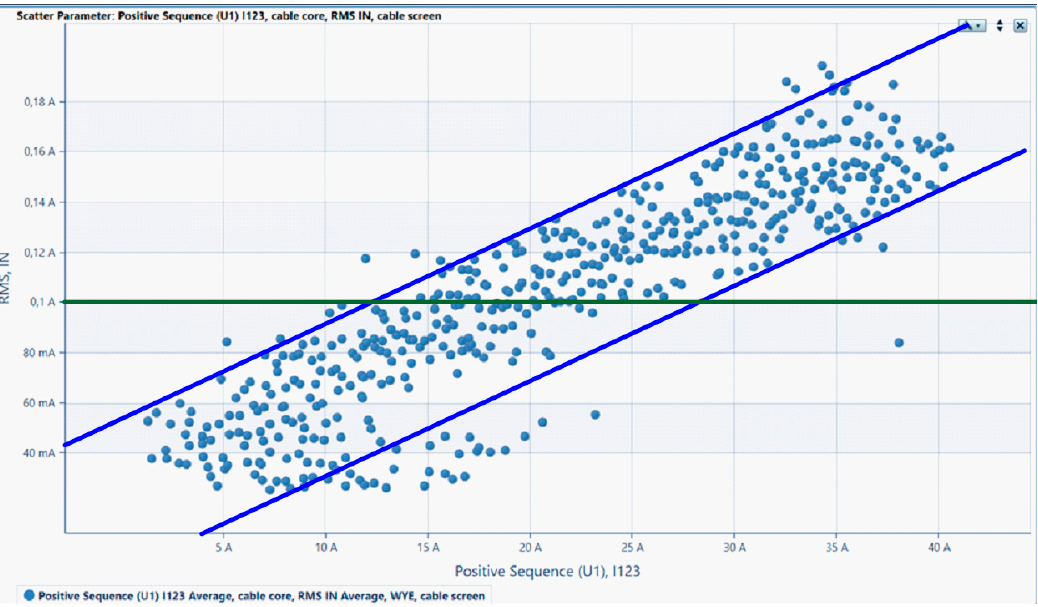
Figure 16. Criterion values used in the presented algorithm: positive sequence load current (first from above), digitally calculated zero-sequence current (in the middle) and residual earthing screen current— I rcs (at the bottom).